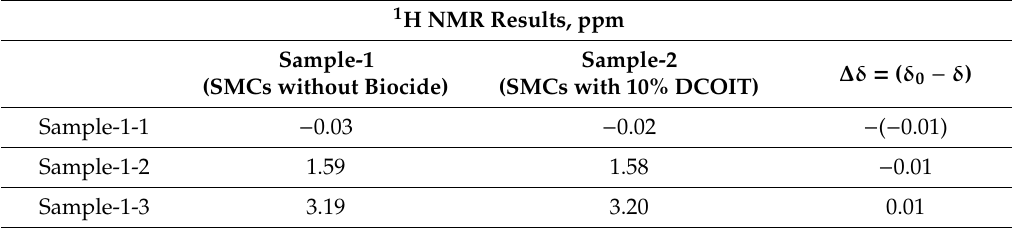
Table 1. Changes of chemical shifts 1 H NMR of TPM in a sample of sub-microcontainers with 10% DCOIT. 10% DCOIT.